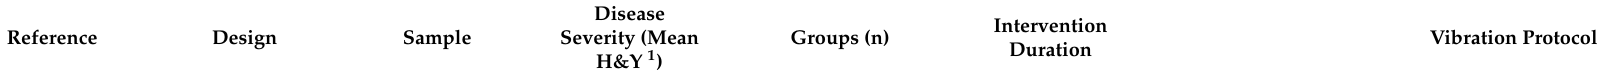
Table 1. General overview of study characteristics regarding the effects of WBV on PD patients or PD animal models (N = 14